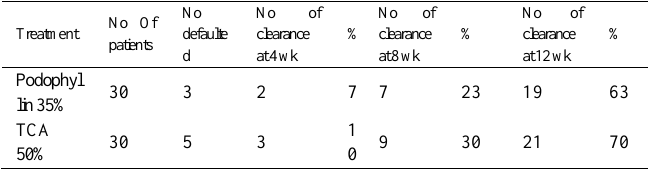
Table 1: Results of using topical podophyllin versus TCA